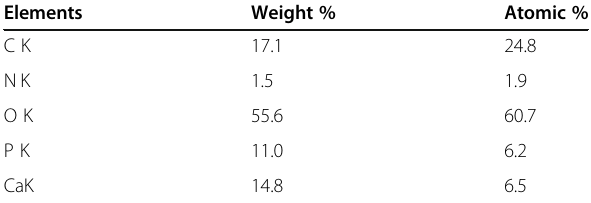
Table 6 EDAX data for 50 mg A. marmelos added CHPD crystal Elements